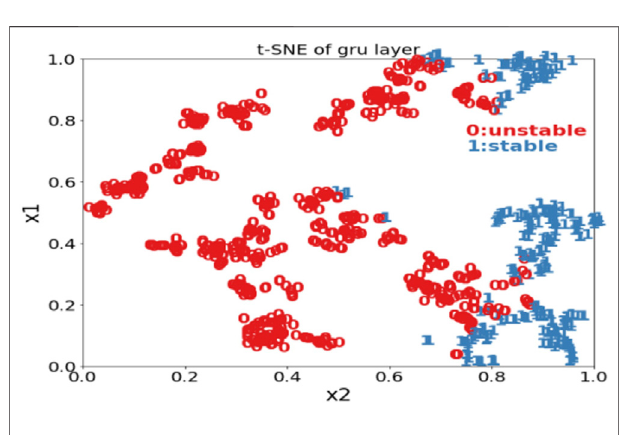
FIGURE 12 | GRU layer.